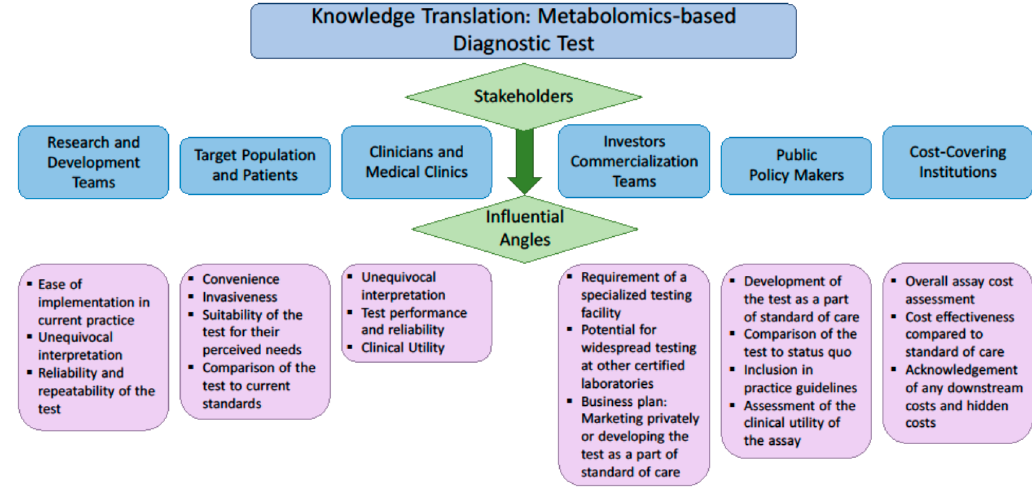
Figure 1. Factors of interest to various stakeholders when evaluating the implementation of a new diagnostic assay.